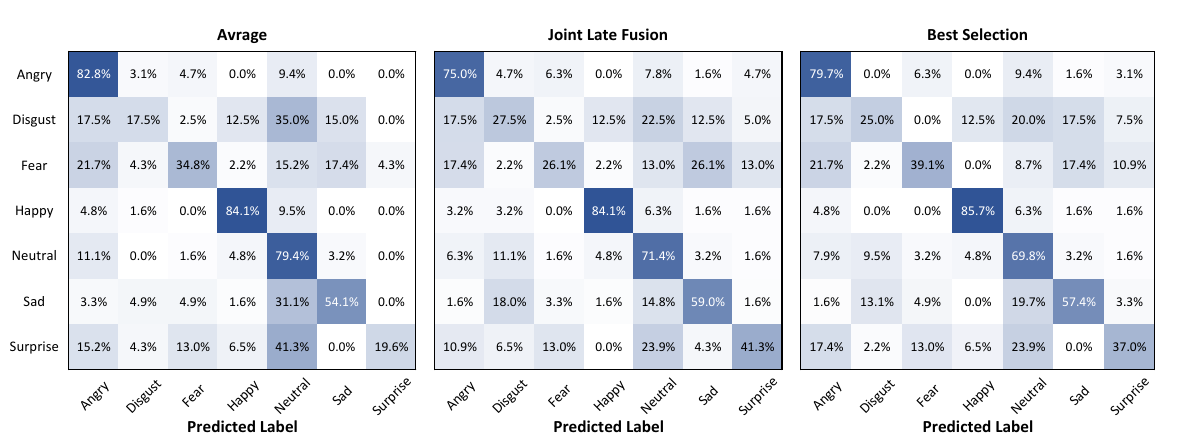
Figure 13. Confusion matrices of the average fusion method, multi-modal join late-fusion method and best selection ensemble method on the AFEW validation